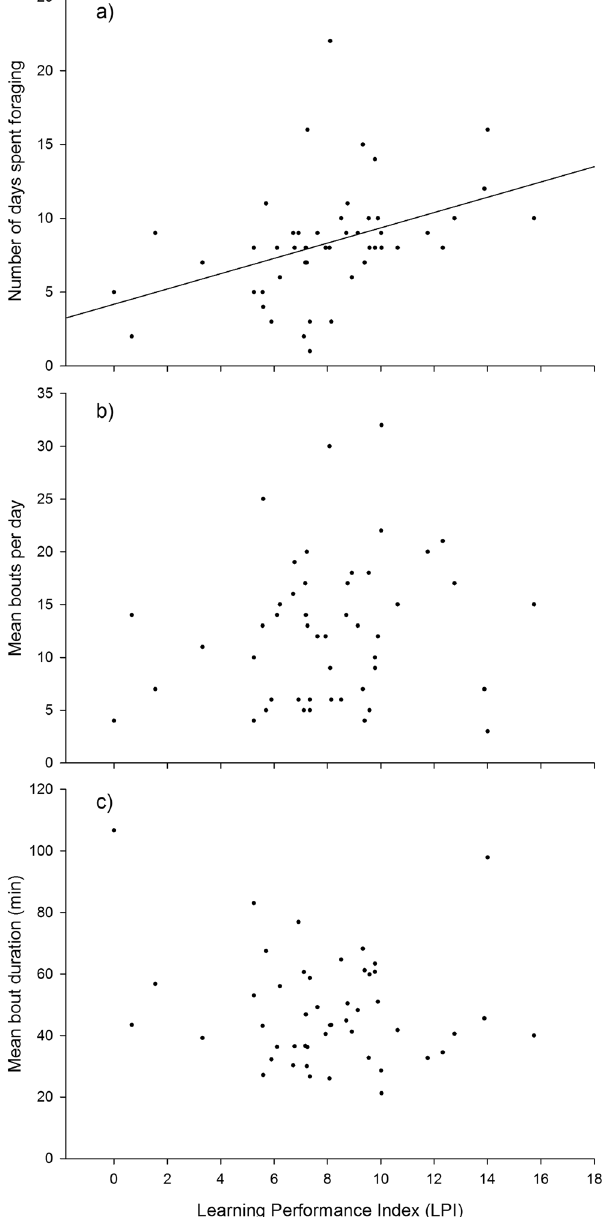
Figure 2. Correlations between Learning Performance Index (LPI) and ( a) the number of days on which each bee foraged, ( b ) the mean number of foraging bouts undertaken per day and ( c ) the mean duration of foraging bouts. A line of best fit, generated from a least-square linear regression, has been added for ease of interpretation to the significant correlation in panel a. Data presented are for all 49 bees that were classified as ‘foraging’ once they were RFID tagged, with each dot representing a single bee. Figures do not describe ‘colony membership’ as this was included as a random factor in the best fitting model. Lower LPI values indicate that the bee was a faster learner (i.e. made fewer